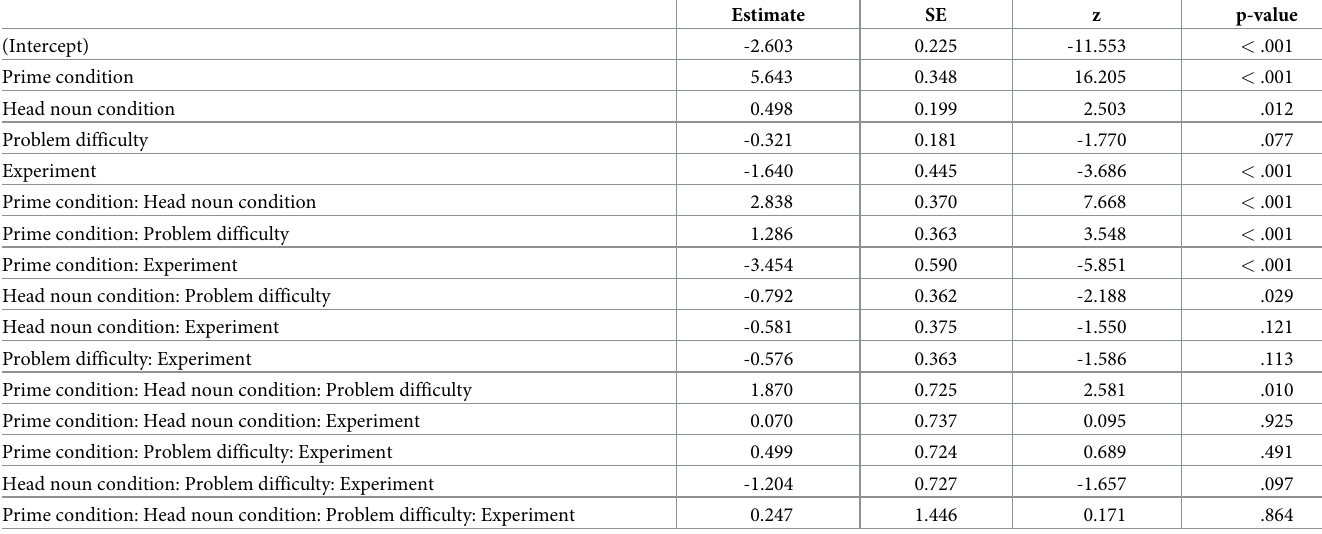
Table 7. Fixed effect estimates (in log odds units), cross experiment analysis (2a and